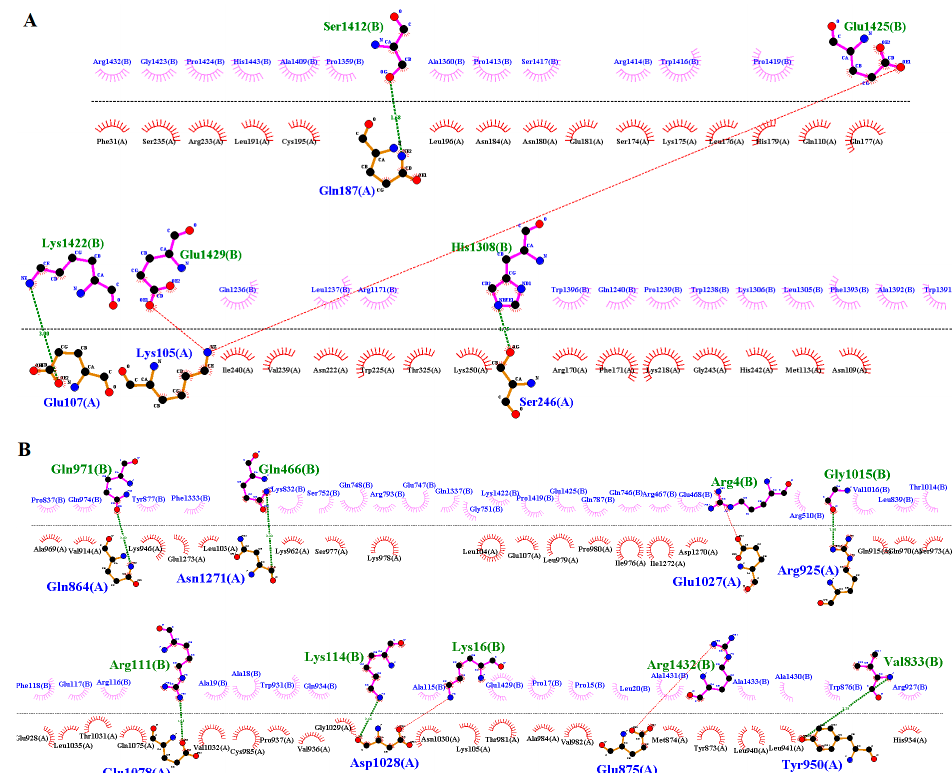
Figure 6. Interactions of wildtype and mutant KIAA0825 with close interactor C1orf167. ( A ) Four residues (chain A) of the wildtype KIAA0825 interacting with five residues (chain B) of C1orf167 via three hydrogen bonds and two salt bridges. ( B ) Eight residues (chain A) of the mutant KIAA0825 interacting with nine residues (chain B) of C1orf167 via 7 hydrogen bonds and two salt bridges.